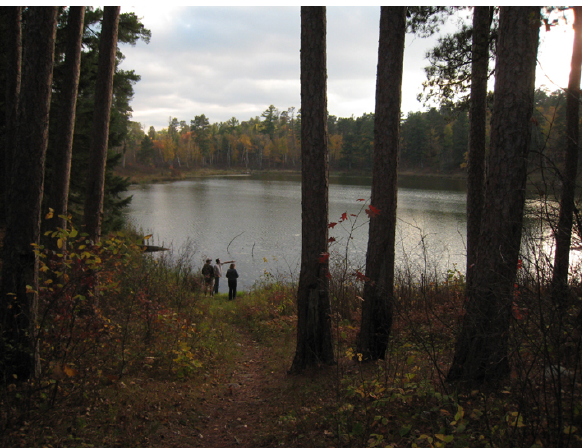
Figure 2. Contoured elevation map of Deming Lake (in feet) along with labeled contoured lines. The locations of the trees sampled are included, along with their respective age classes based on the size of the triangle. Note that some trees were sampled within close prox- imity to one another, so not all samples may be represented on the